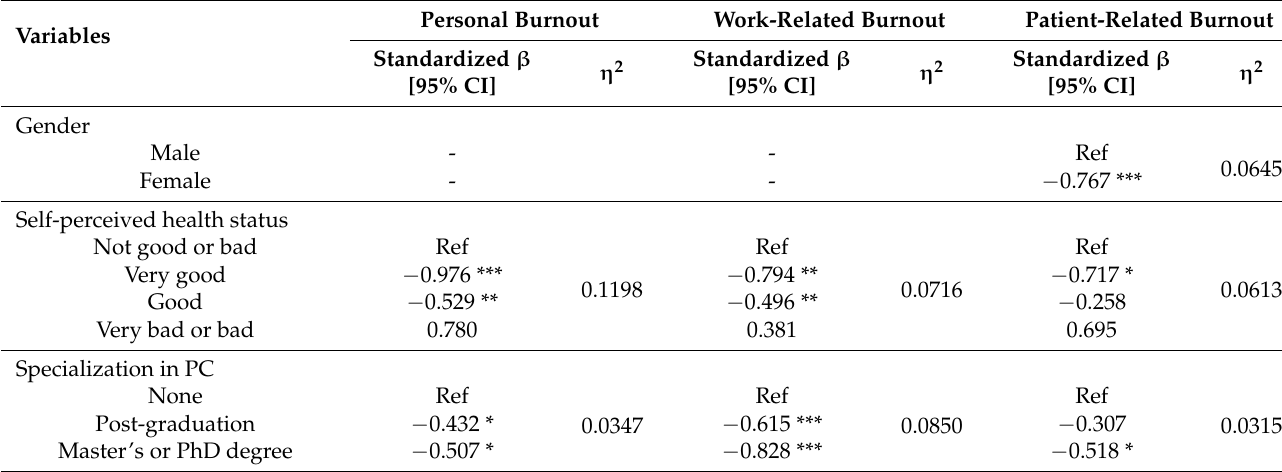
Table 2. Standardized regression coefficients and semi-partial squared correlations in multivariable models for the subscales of burnout according to CBI as outcomes and personal, work and COVID-19 variables as predictors.